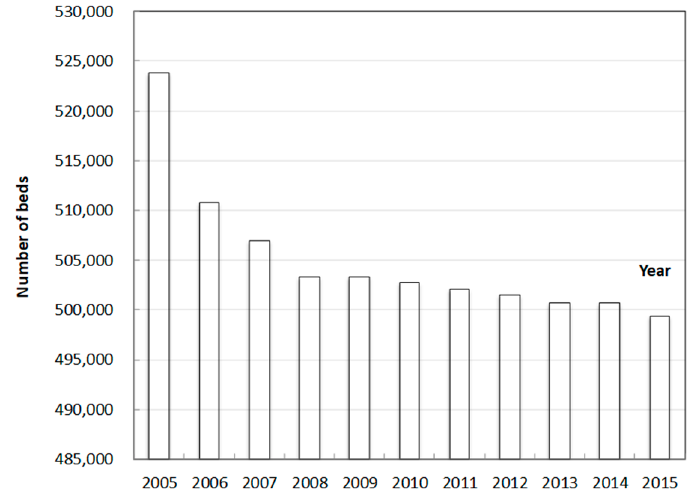
Figure 6. Relationship of beds per hospital in the years 2005 to 2015 in Germany.